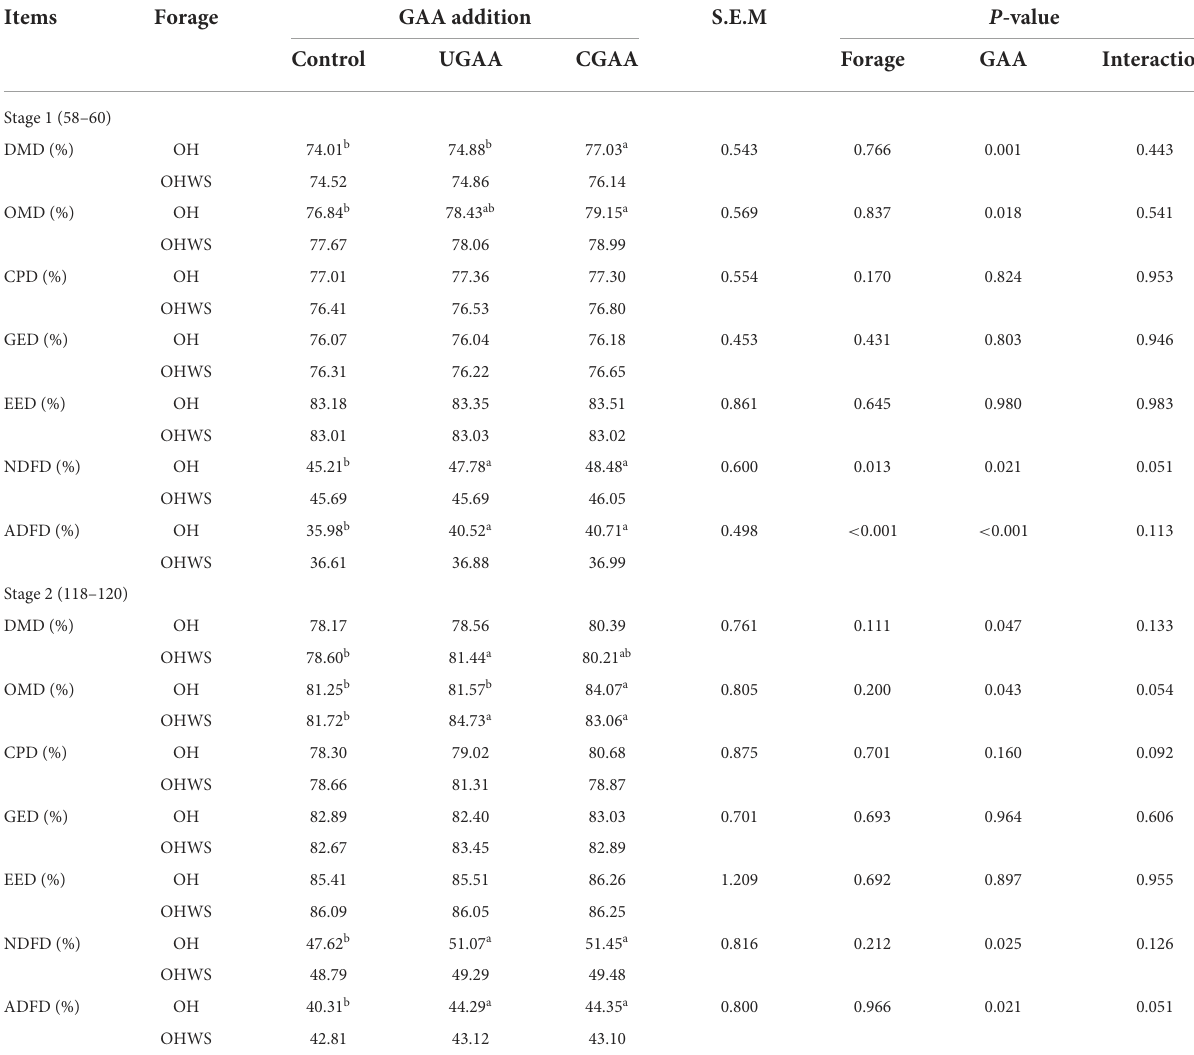
TABLE 4 Effects of forage type and guanidine acetic acid (GAA) addition on nutrient digestibility in feedlotting lambs at different feeding stages (stage 1, 58–60 day; stage 2, 118–120